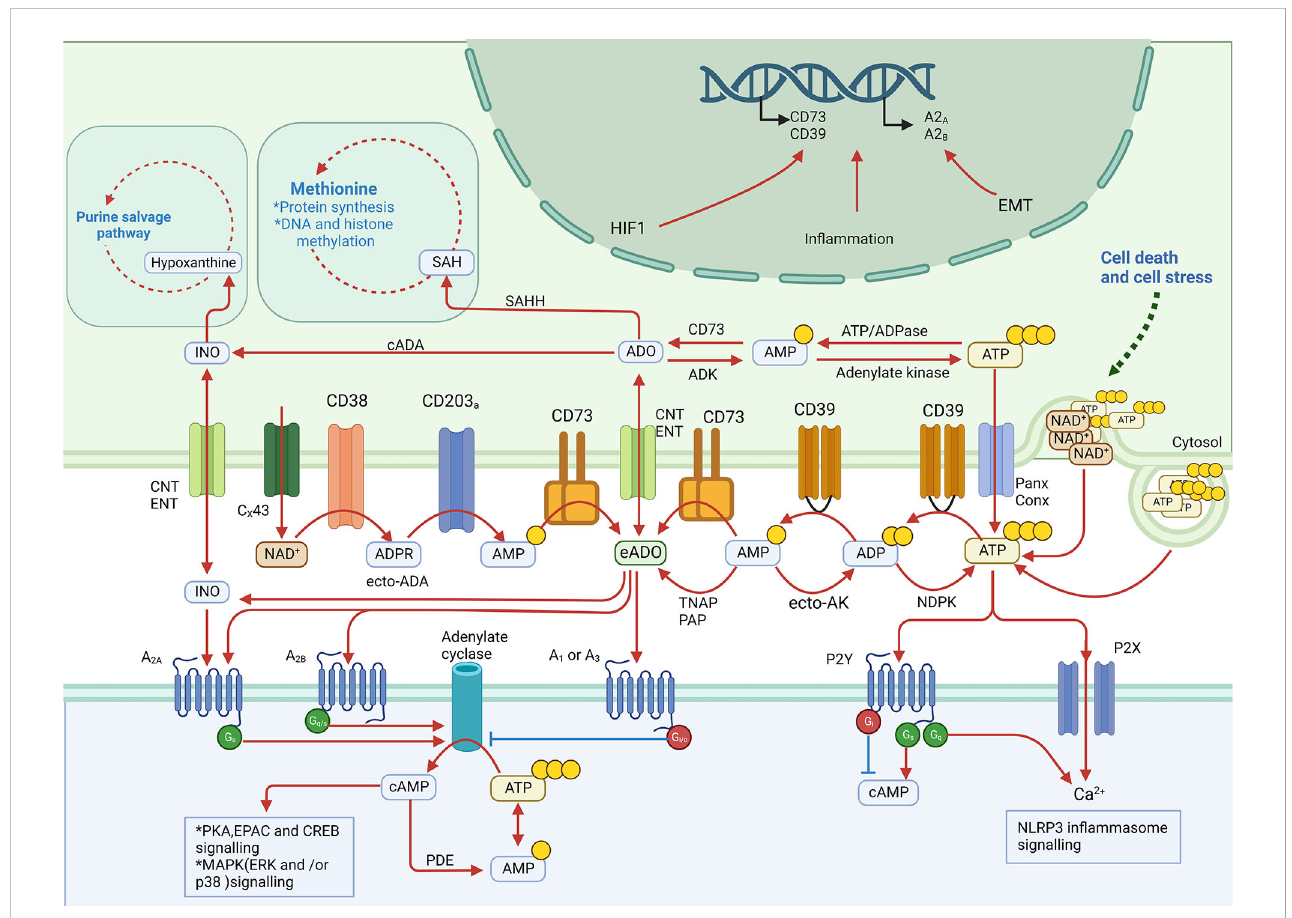
FIGURE 1 eADO metabolic pathways: production, degradation, and